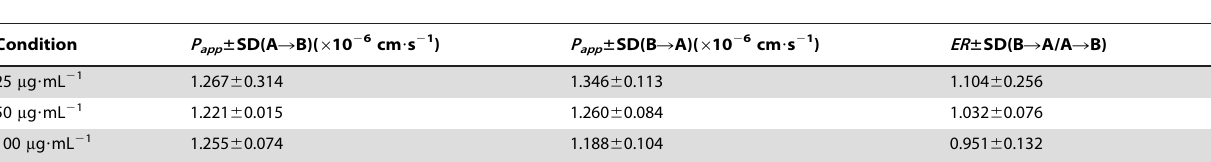
Table 1. Various concentrations of geniposide permeability across the HNEC monolayer.